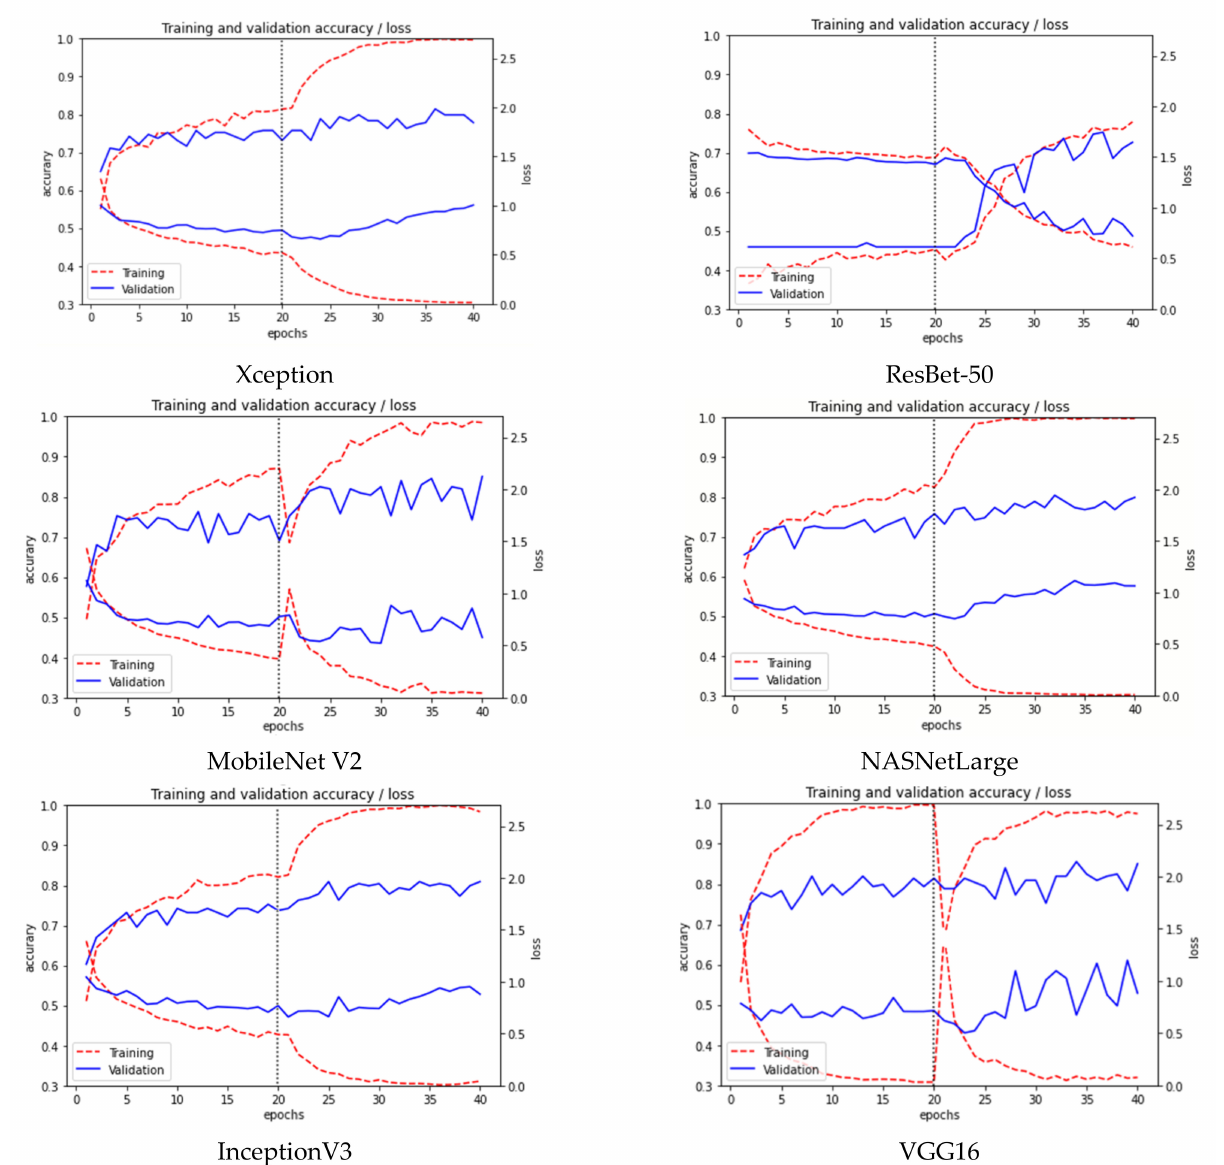
Figure 8. Accuracy for several Transfer Learning models for training and validation set.